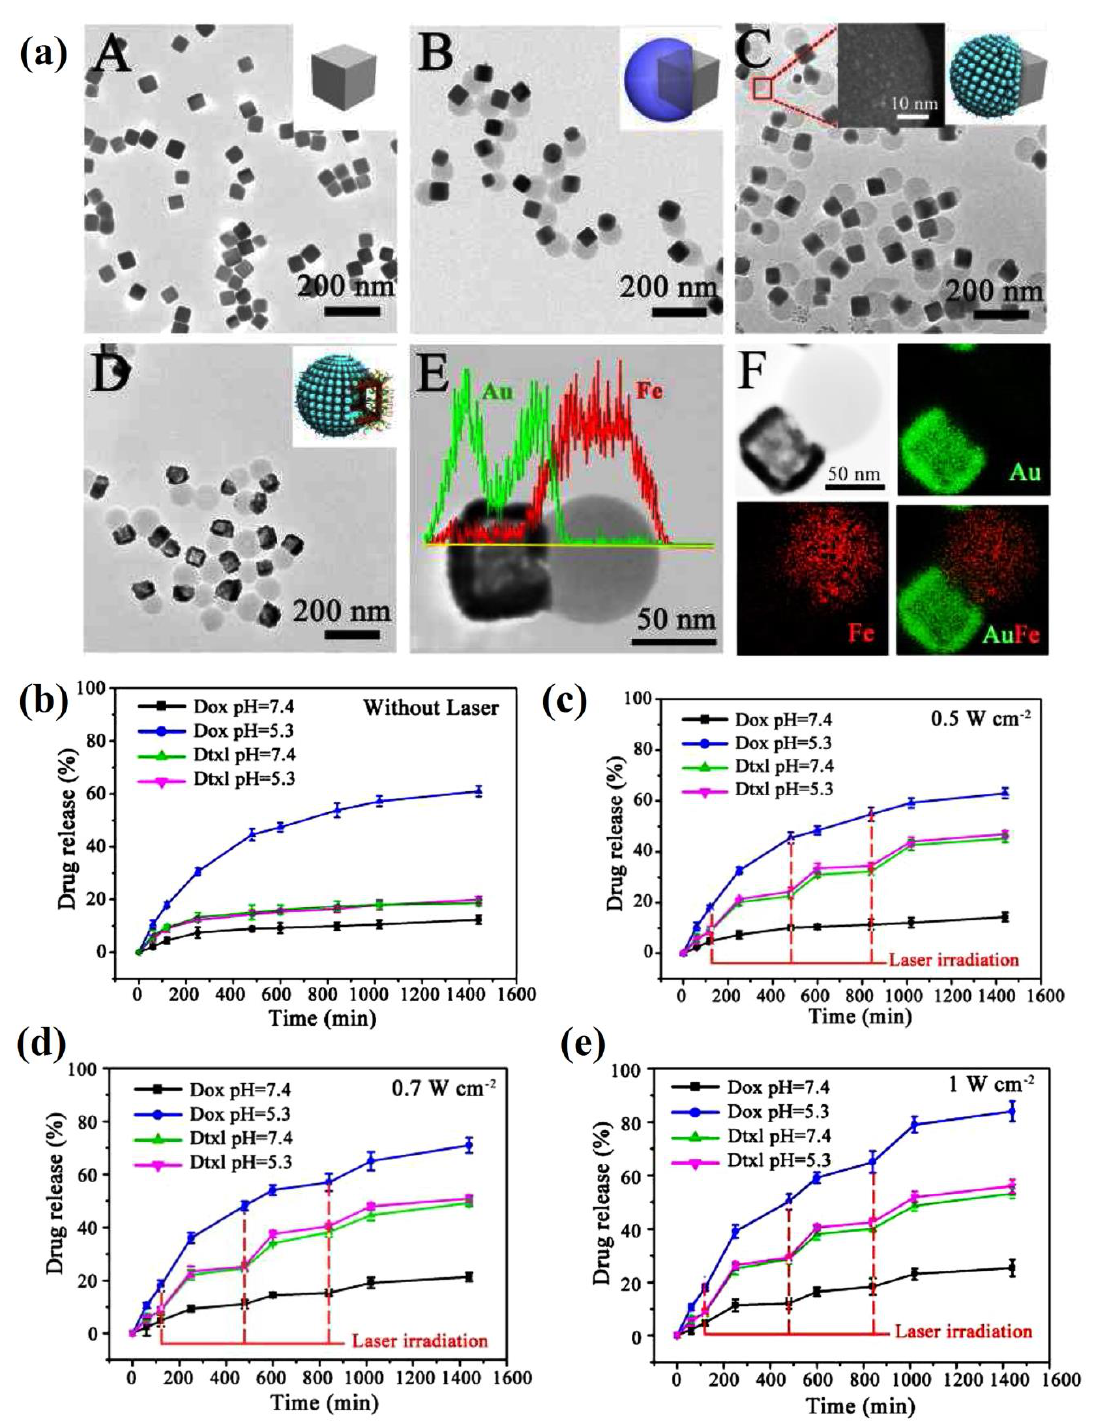
Figure 8. ( a ) Step-by-step synthesis AgNC ( A ), AgNC/PAA ( B ), AgNC/Fe(OH) 3 -PAA ( C ), and AuNC/Fe(OH) 3 -PAA ( D ), and images ( E , F ) are the proof of the asymmetrical structure of nanopar- ticles by elemental line scan and elemental mapping. ( b – e ) Release patterns of Dox and Dtxl at various time intervals in PBS (pH = 5.3 and 7.4) under and without NIR irradiation with various intensities (0.5, 0.7, and 1 W cm − 2 , for 5 min). Reproduced from Zhang et al. [165], with permission from